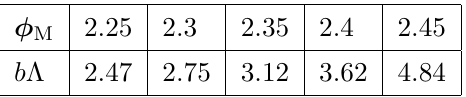
Table 2 . Approximate width of the plateau